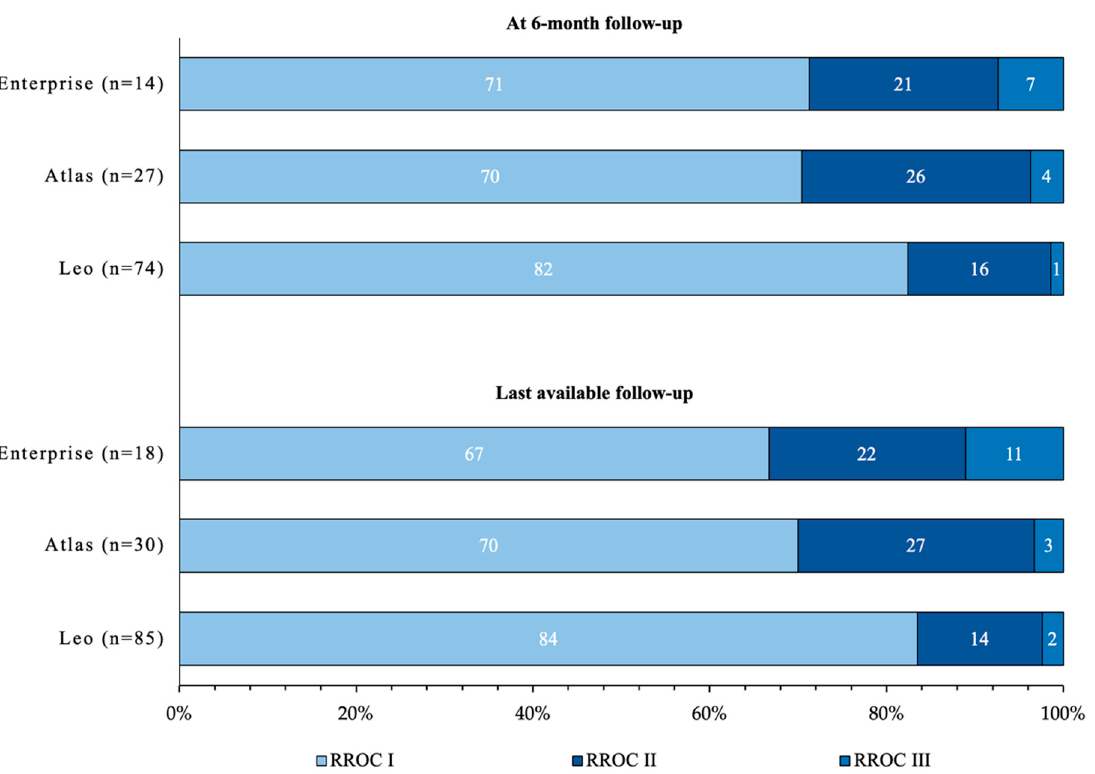
Figure 1. Rates of aneurysm obliteration assessed with Raymond–Roy Occlusion Classification (RROC) stratified by stent model and time of follow-up. Table 2. Procedural complications of all patients and grouped by stent